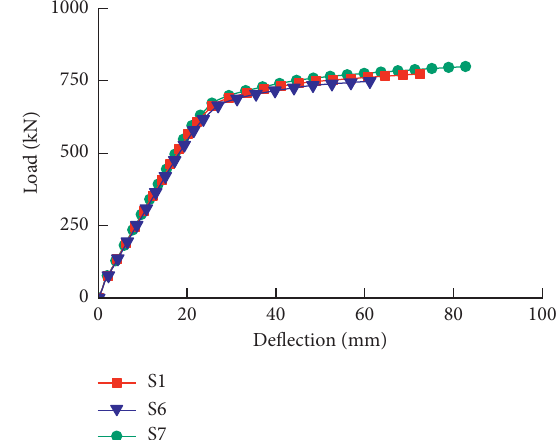
Figure 10: Load vs. midspan deflection with different concrete compressive